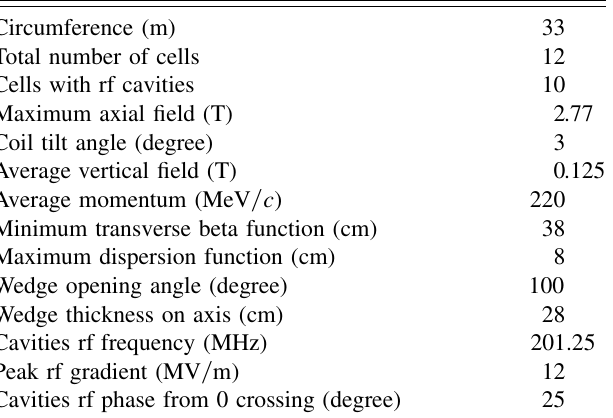
TABLE I. RFOFO ring